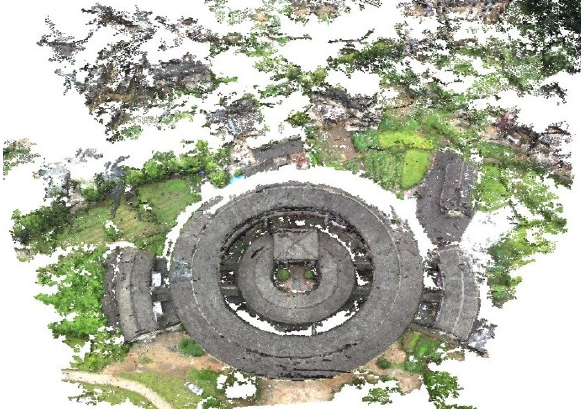
Figure 3. 3D point clouds from UAV full-set video image sequences